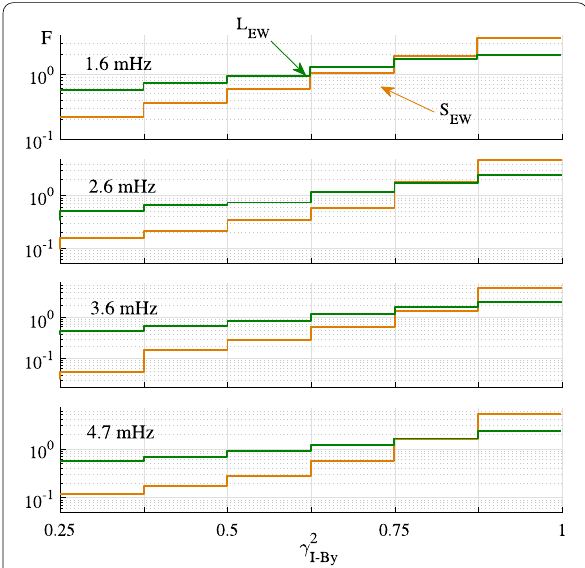
Fig. 8 γ 2 I − By empirical PDF for the E–W large- ( L EW ) and small-scale ( S EW )